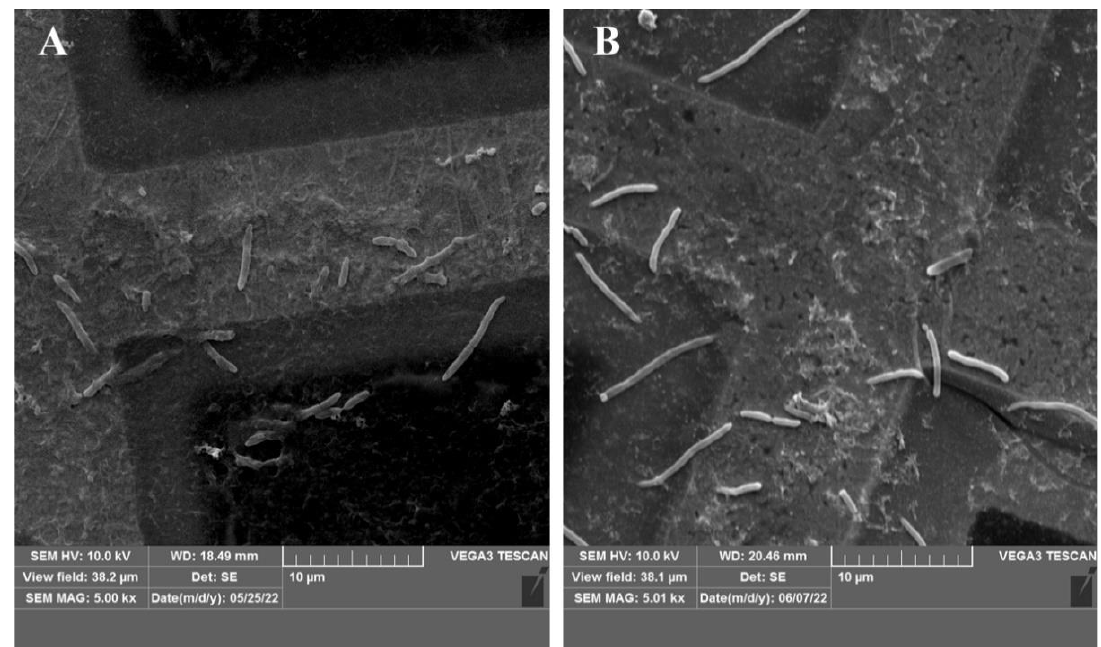
Figure 6. SEM micrographs of the mixtures of bacteria P. syringae and phage phi6 ( A ), compared to the same mixture of P. syringae and phi6, but with the addition of 0.049% Echinacea purpurea extract ( B ).